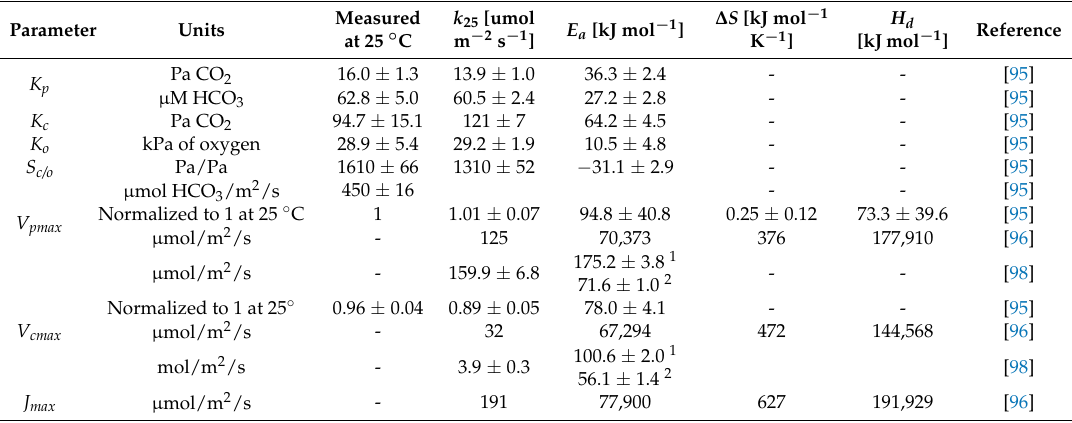
Table A3. C 4 Photosynthesis Temperature Response Parameters (with standard